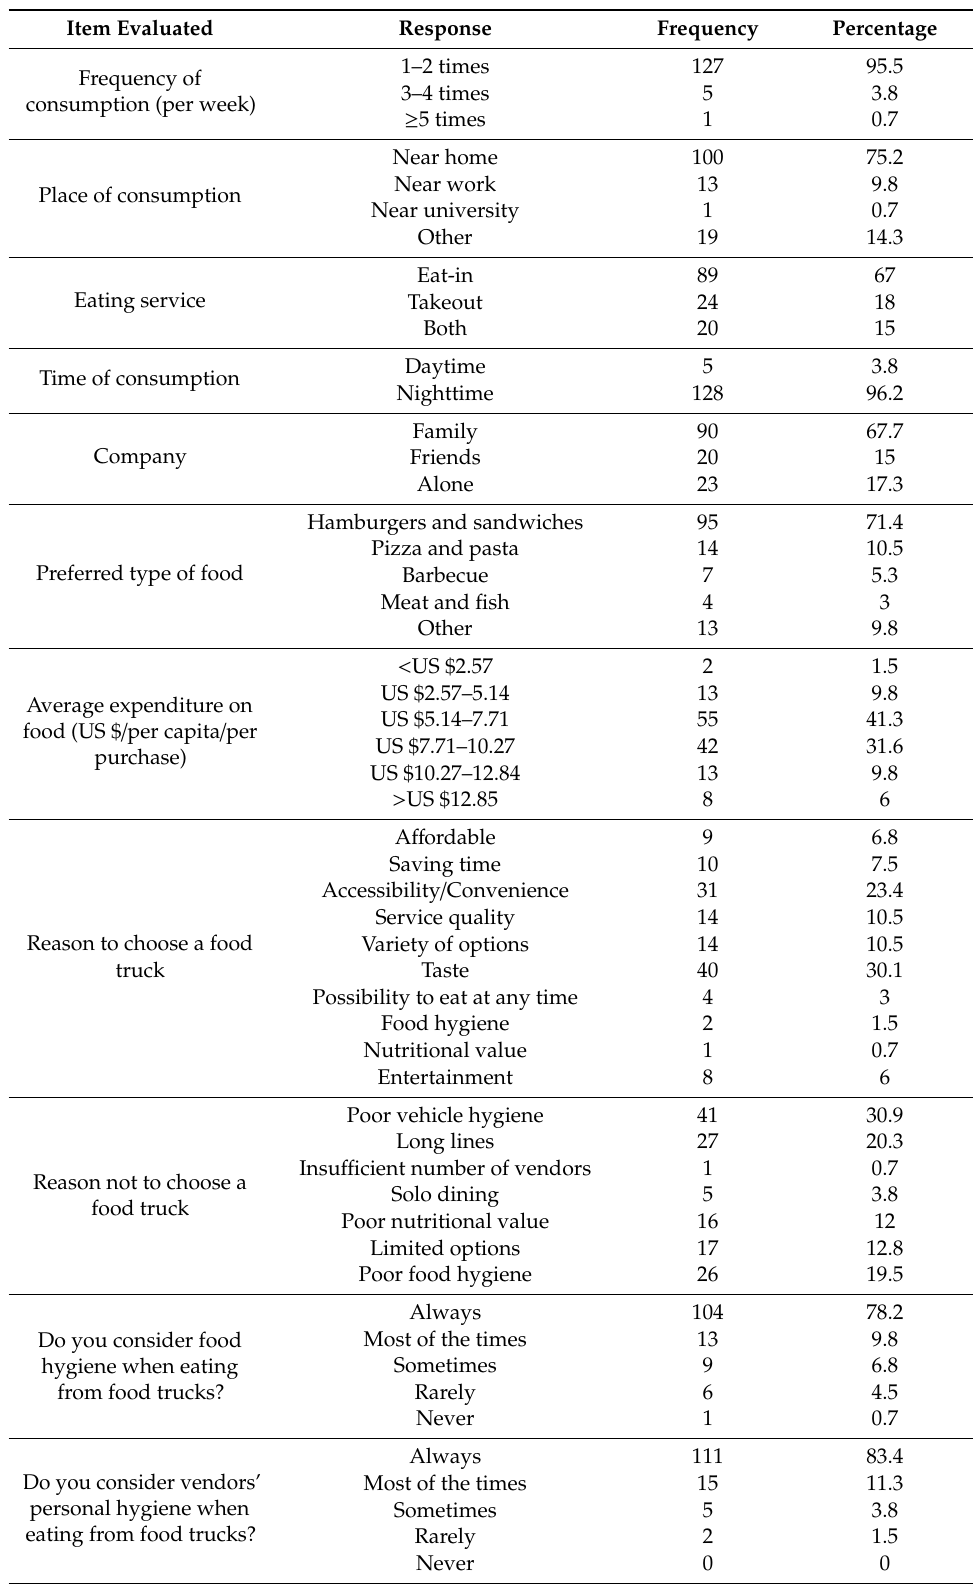
Table 2. Choices and preferences of food truck consumers studied in the Federal District, Brazil ( n =